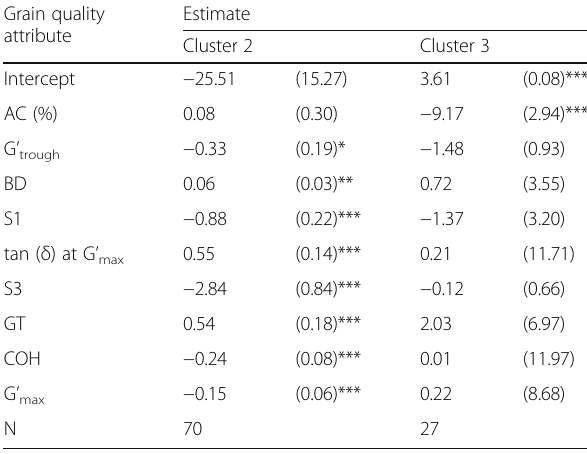
Table 5 Summary of multinomial logistic regression for variables characterising the different rice quality clusters. Cluster 1 is not shown in Table 5 because it is the reference cluster. Table 5 indicates the multinomial log-odds that samples represented in Cluster 2 or in Cluster 3, were compared to reference cluster 1 to calculate every unit increase or decrease in the different grain quality attributes included in the multinomial logistic regression model